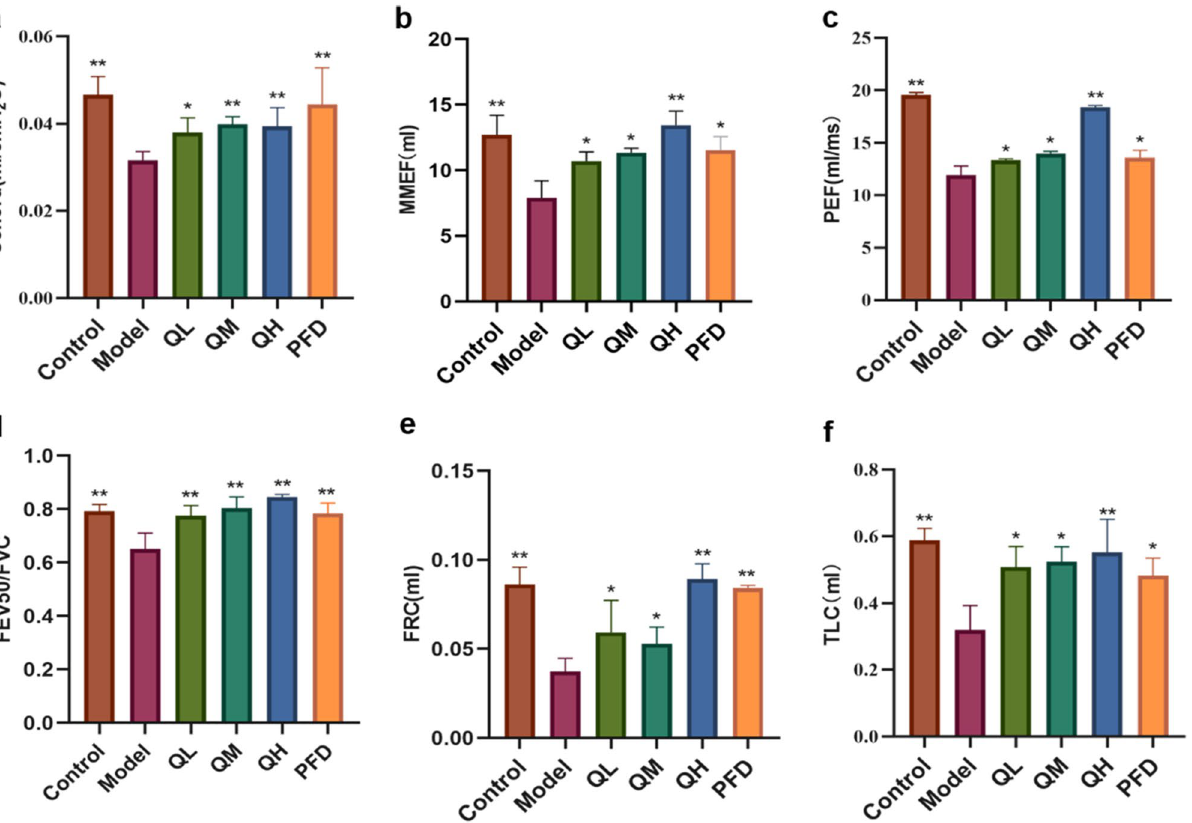
Figure 2. Effects of pulmonary function in each group. ( a ) Cchord: an index reflecting alveolar compliance and expansibility, representing the effect of changes in thoracic pressure on lung volume. It also reflects pulmonary tissue elasticity and airway resistance. ( b ) MMEF: It reflects the detection index of alveolar diffusion function. ( c ) PEF: it mainly reflects whether the large airway is blocked. ( d ) FEV 50/FVC: it is the volume of exhaled volume after maximum deep inhalation and maximum exhalation for 50 ms in mice, Obstructive or mixed type is slightly reduced to significantly reduced. ( e ) FRC: The decrease indicates a reduction in alveolar function. ( f ) TLC: The decrease is mostly related to restrictive ventilation disorder, suggesting that it is related to PF. (n = 3; data are expressed as mean ± SD. * P < 0.05, ** P < 0.01, compared with Model